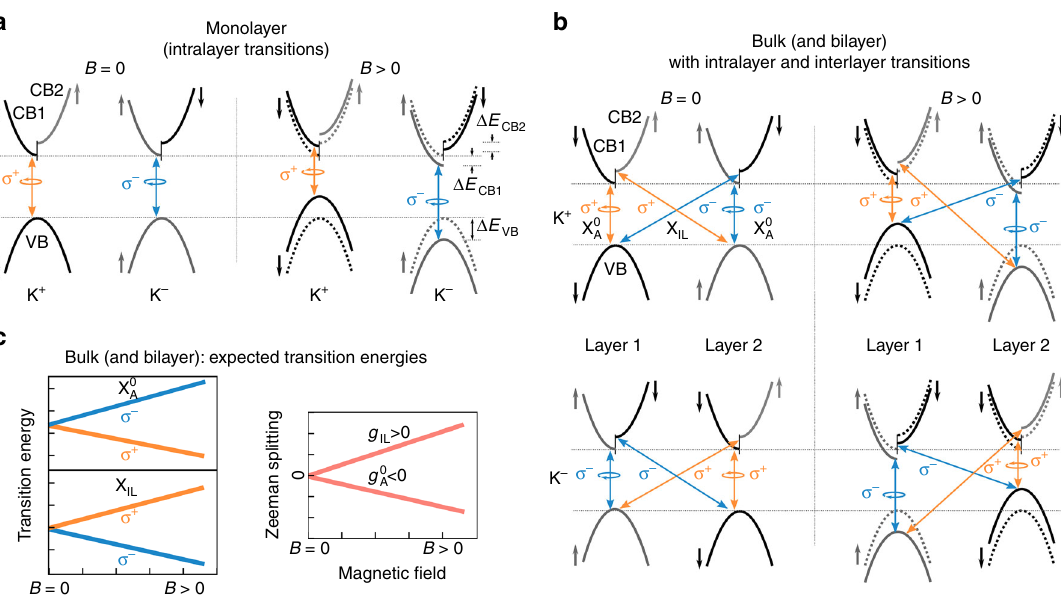
Fig. 4 Transition selection rules for intra- and interlayer excitons. Helicity-resolved optical selection rules for the transitions at B = 0 ( left ) and B > 0 ( right ) between the valence band VB and the spin – orbit – split conduction bands CB1 and CB2 (with carrier spins marked) in the case of a monolayer and b bulk (and bilayer) 2H-MoTe 2 . The dashed lines in the right panels indicate the band positions for B = 0. Vertical and diagonal arrows indicate intralayer ( X 0 interlayer transitions ( X IL ). c Theoretically expected trends of the excitonic transition energies and the Zeeman splittings for the intralayer ( X 0 interlayer ( X IL )